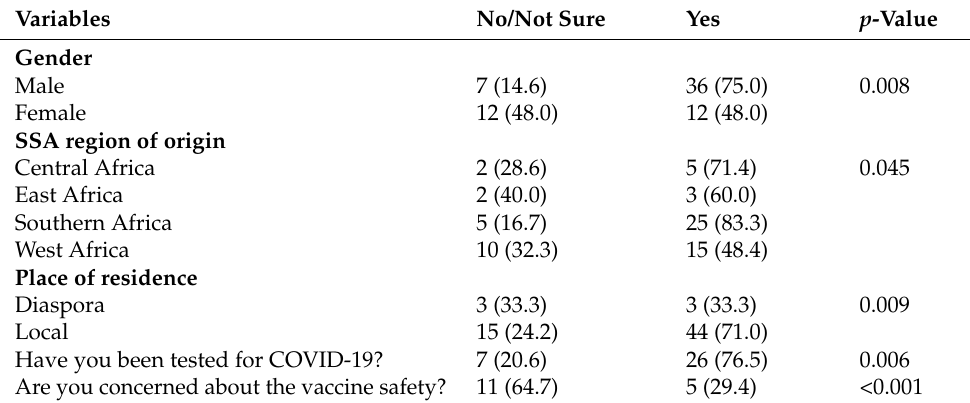
Table 4. Association between COVID-19 vaccine hesitancy or refusal and the demographic variables of the participants. Only significant variables are